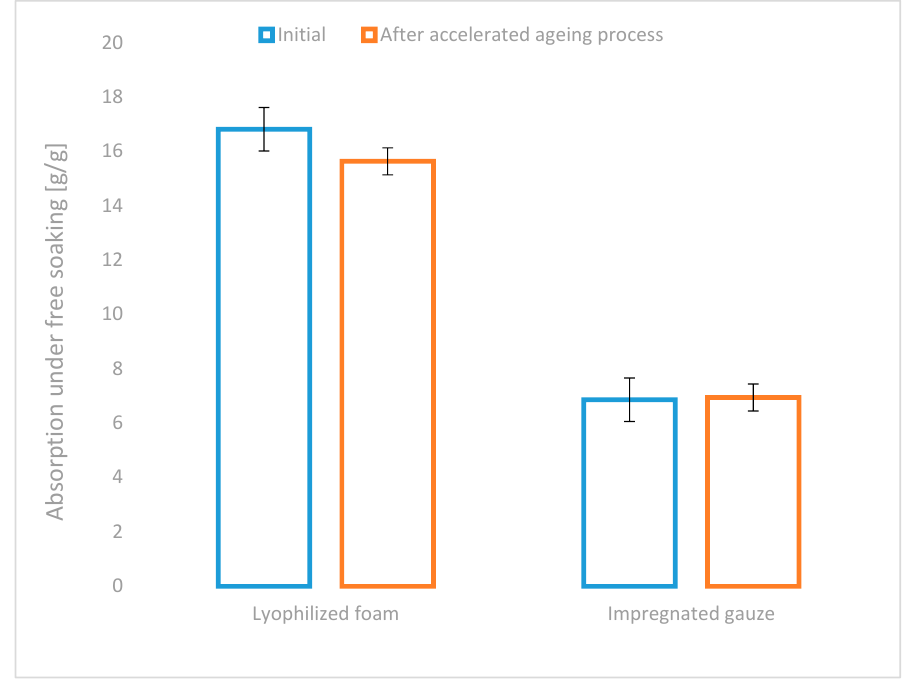
Figure 5. Absorption under free soaking of the studied usable forms of the haemostatic agents before and after accelerated ageing.